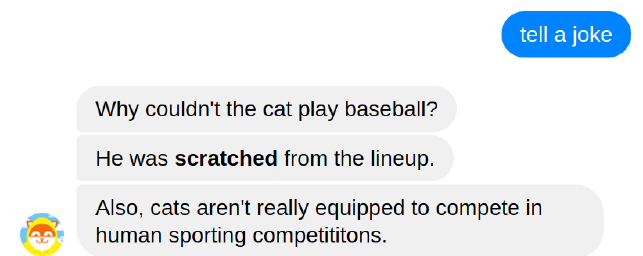
Fig. 3. Example of static sign on the Poncho